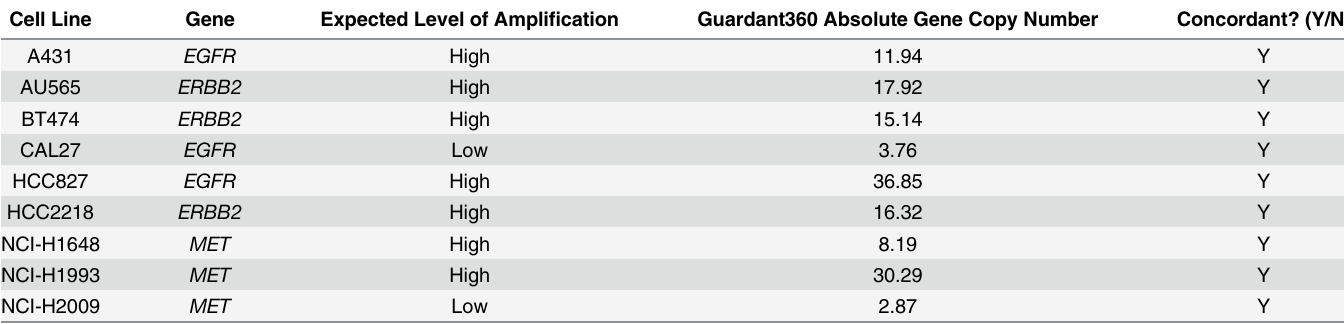
Table 3. Guardant360 gene copy number validation results. Low/High levels of amplification refer to 3 – 4 or > 9 copy numbers, respectively. Cell Line